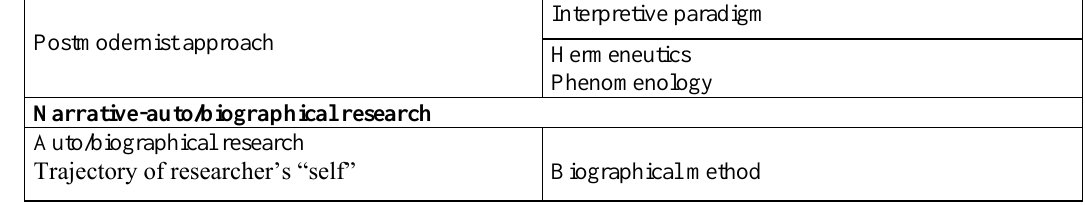
Fig. 1. Triangulation of methods; source: compiled by the author